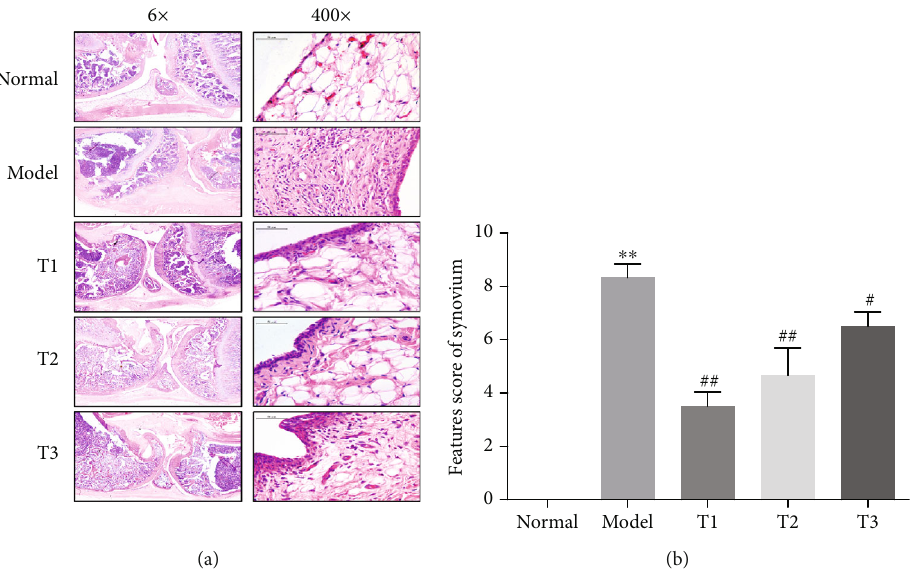
Figure 2: WB alleviated the joint in fl ammation of CIA rats. (a) Representative histopathological fi nding of knee joint from each group. The sections of knee joint were stained with H&E (magni fi cation 6x and 400x). (b) Features score of synovium from each group. Data were mean ± SD , n = 6 . ∗∗ P < 0 : 01 compared with the normal group; ## P < 0 : 01 and # P < 0 : 05 compared with the model group.